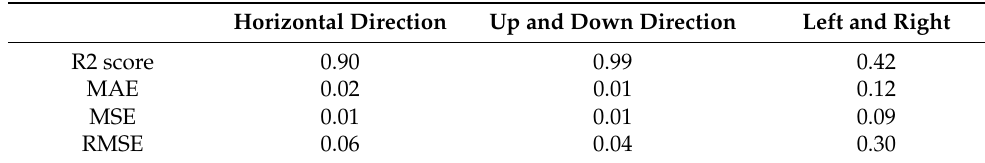
Table 1. Data on machine learning evaluation